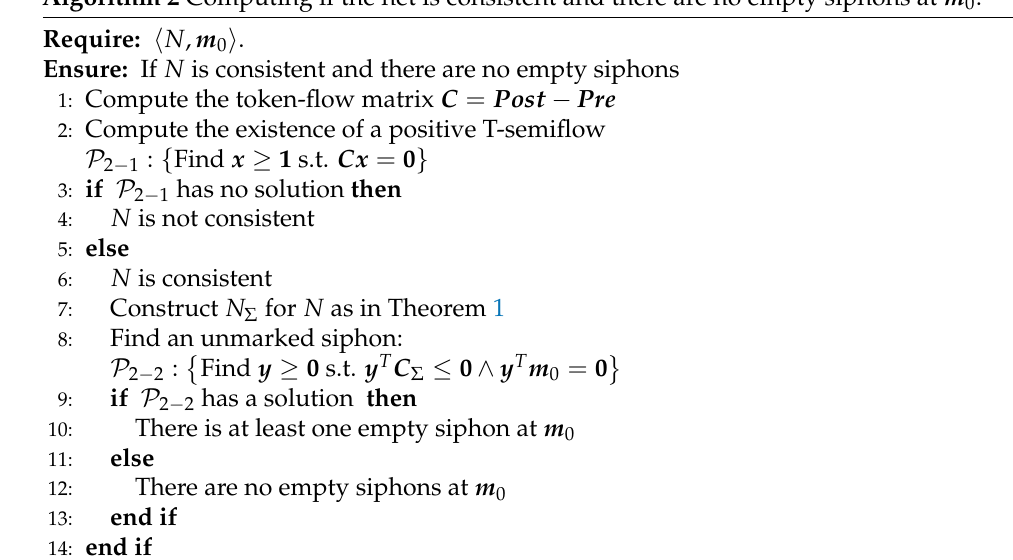
Algorithm 2 Computing if the net is consistent and there are no empty siphons at m 0